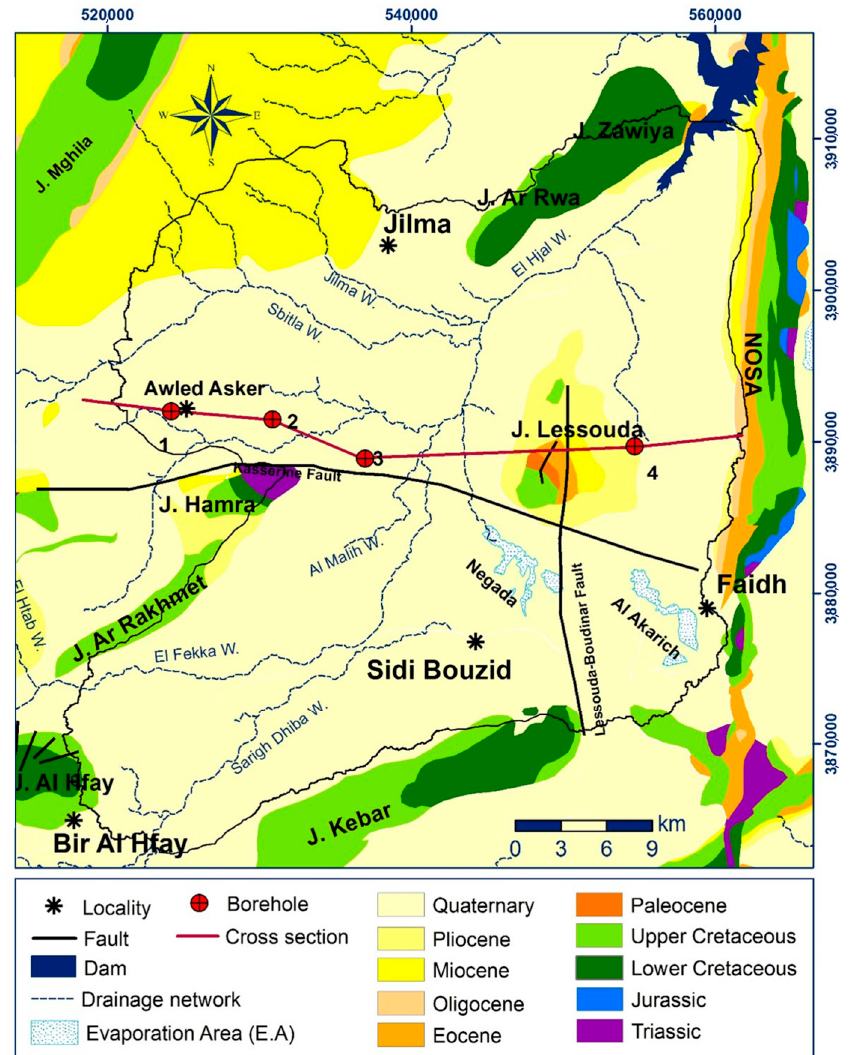
Figure 2. Geological map of the study area (modified from the geological map of Tunisia at 1/500 000) [37].